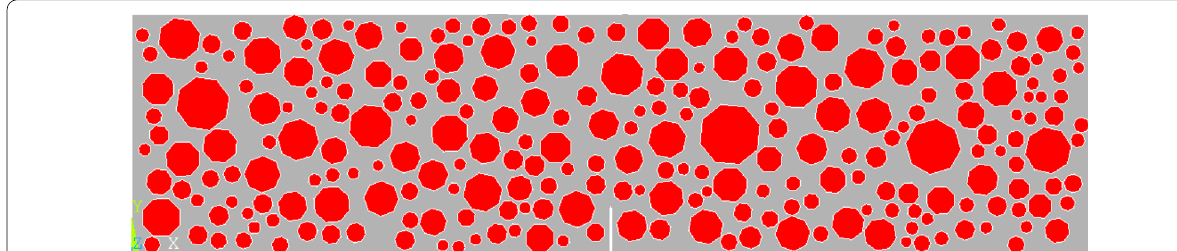
Fig. 7 Geometric model of concrete three-point bending beam